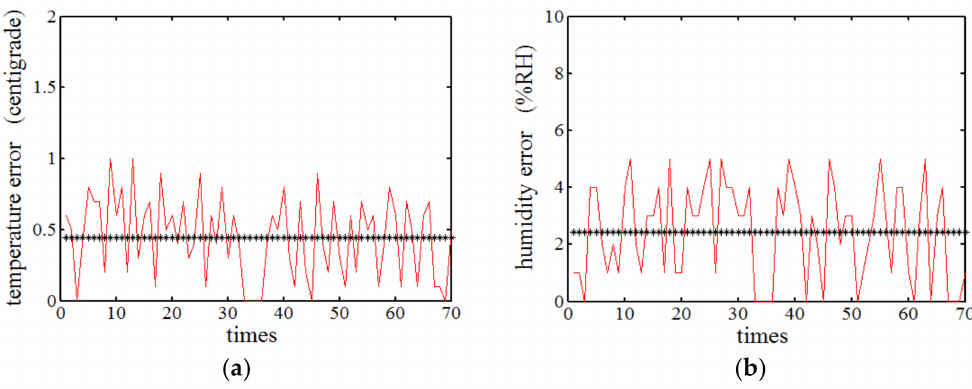
Figure 11. The measurement error. ( a ) temperature error ( b ) humidity